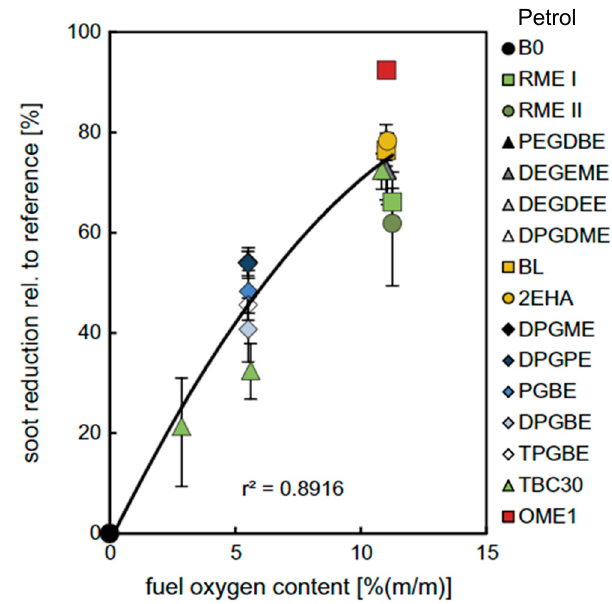
Figure 9. Soot ( PM ) reduction as a function of fuel oxygen content [67].